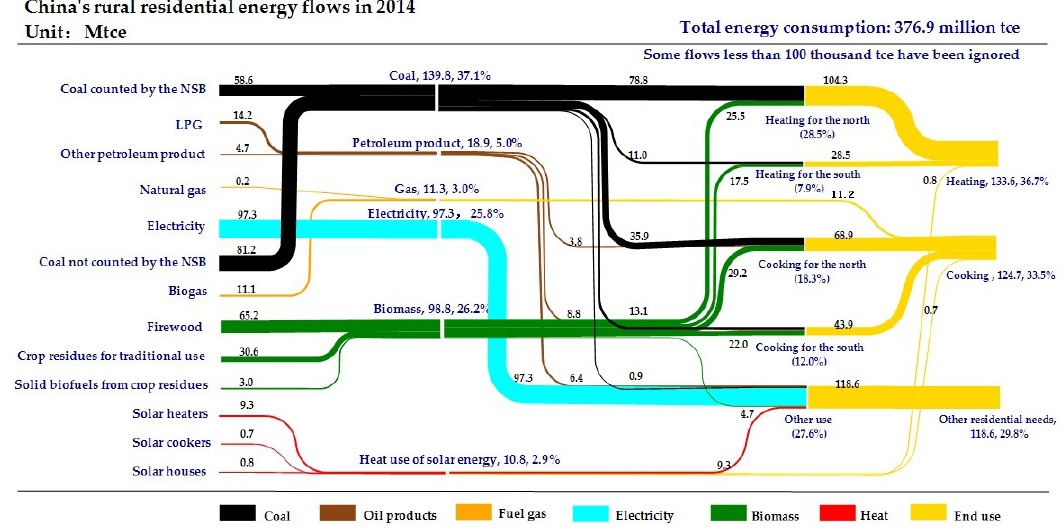
Figure 2. Energy allocation Sankey diagram of China’s rural households in 2014.